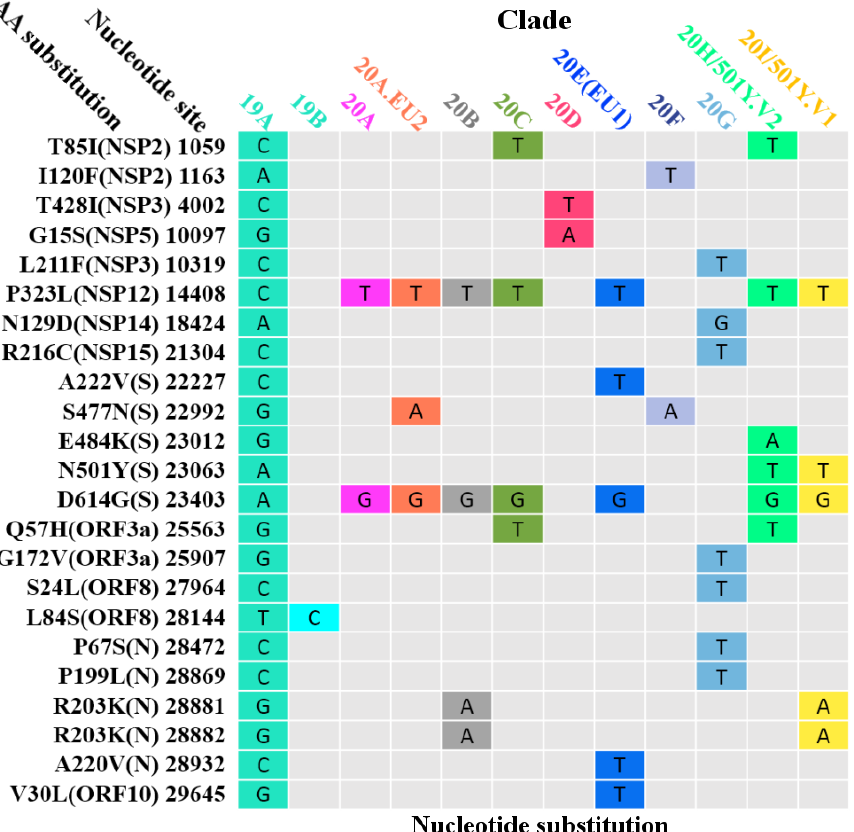
Figure 6. The substitution matrix at the nucleic acid level. Nucleotide substitutions showed in this figure are the main substitutions characterizing the SARS-CoV-2 clades.